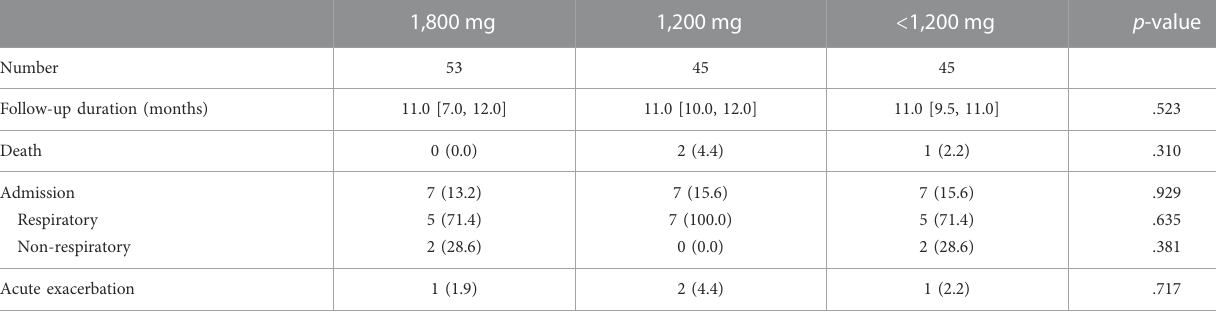
TABLE 2 Clinical outcomes according to the most frequently used pirfenidone dose.